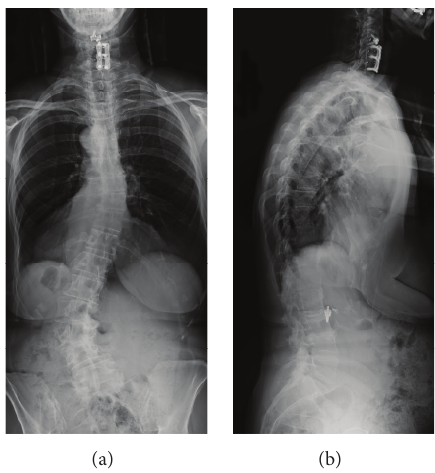
Figure 1: Posterior-anterior (a) and lateral (b) preoperative 3-foot scoliosis X-rays. Note the prominent curvature of the lumbar spine, which resulted in progressive symptoms.